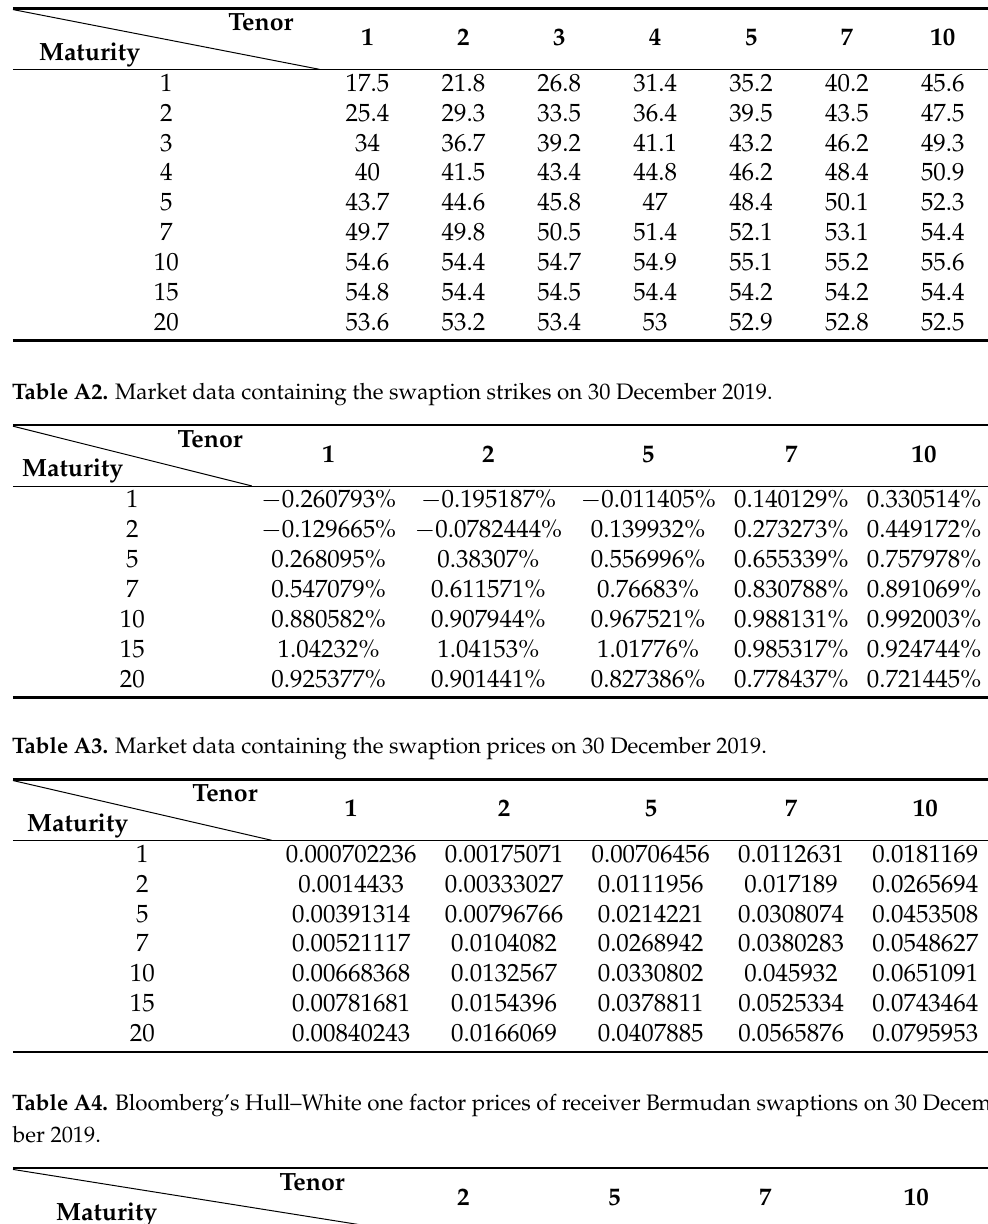
Table A1. Market data containing the volatility surface for the swaption pricing on 30 December 2019